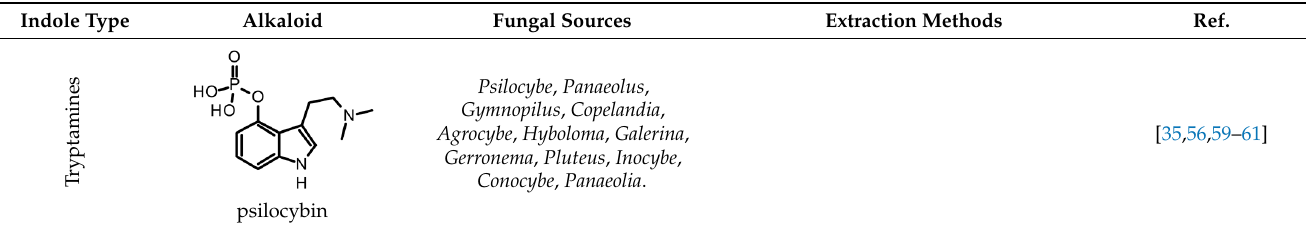
Table 3. Structure, sources, and extraction methods of some representative mushroom-derived indole alkaloids.